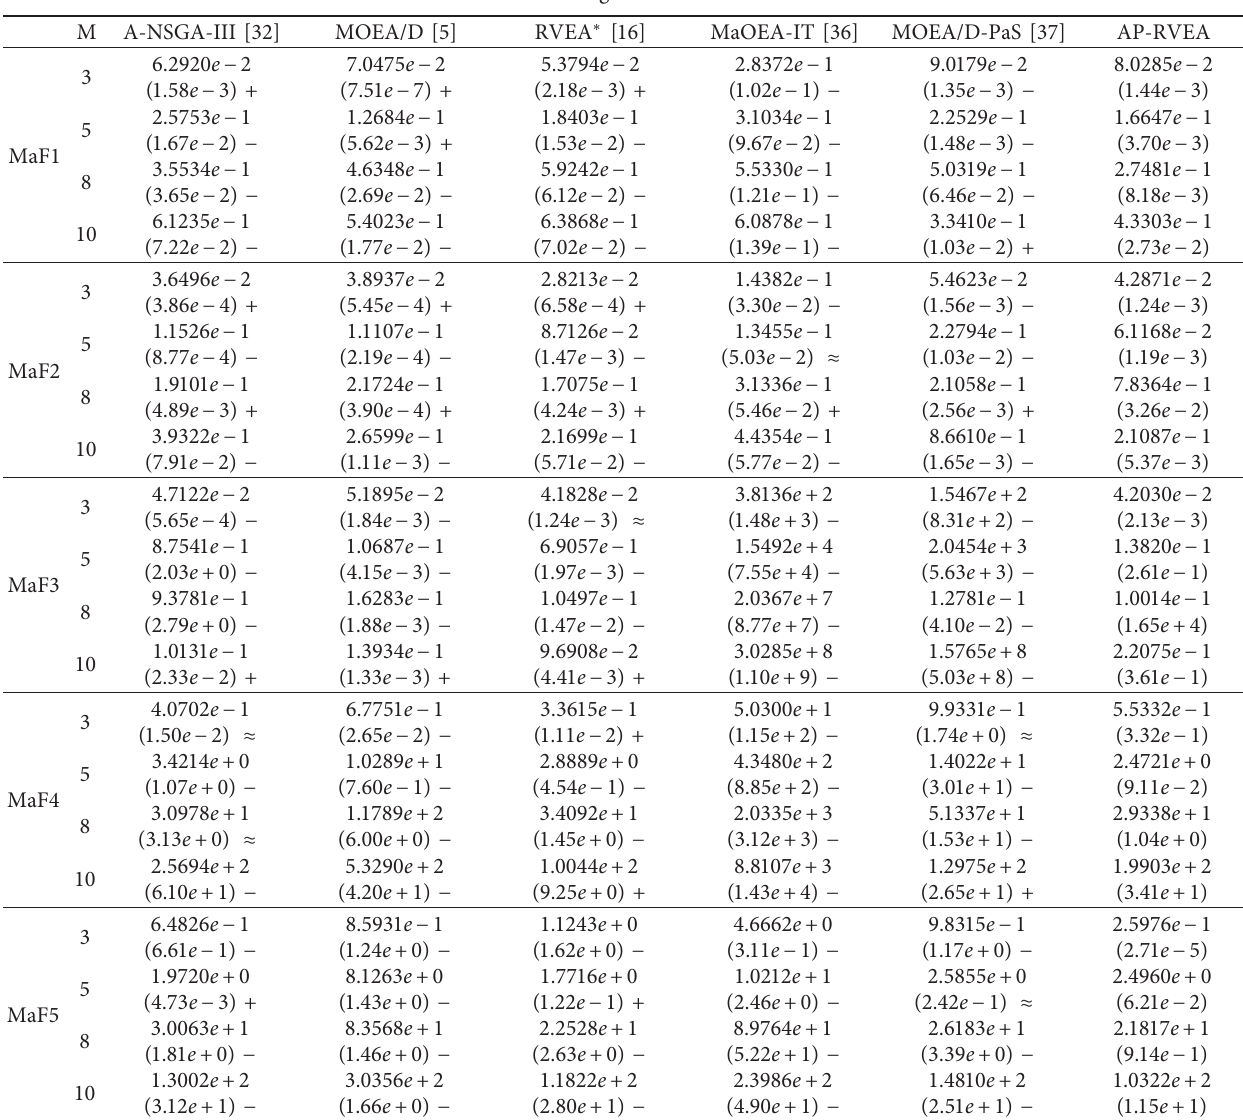
Table 2: IGD results of the 6 algorithms on benchmarks